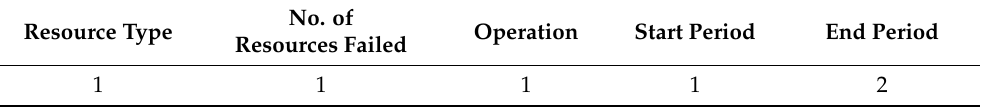
Figure A1. ( a ) A nominal solution represented in STN 1 ( V 1 , A 1 ) ; ( b ) The nominal flows of the second type of tasks influenced by the resource failure represented in STN 2 ( V 2 , A 2 ) . Table A3. Information of a Resource Failure.